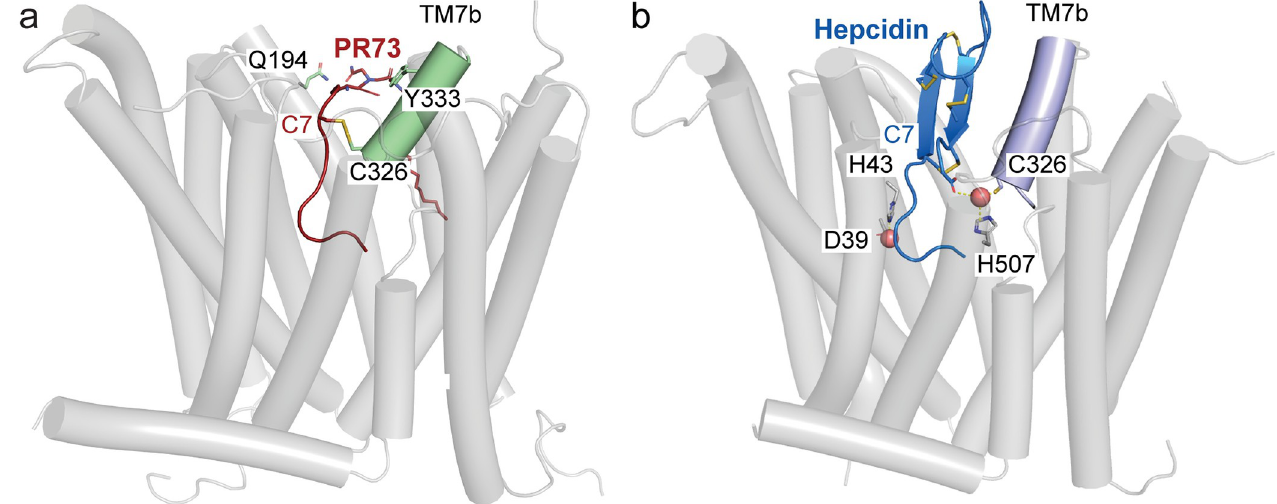
Fig 8. Structural comparison of PR73 and hepcidin-bound HsFpn. Side views of HsFpn-PR73 ( a ) and HsFpn-Hepcidin (6WIK) ( b ) highlight the disulfide bridge and metal ion coordination. In ( a ), TM7b is colored pale green and PR73 in brick red. In ( b ), TM7b is colored in light blue, hepcidin shown as marine cartoon with cysteine residues, and C-terminal carboxylate shown as